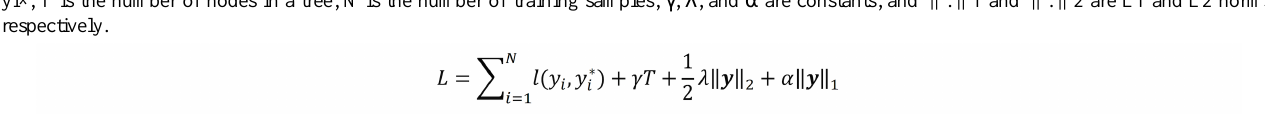
Figure 7. Cost function for training a new tree added at iteration t; where gt(.) is the prediction score provided by the new tree. See Figure 6 caption for more details on the